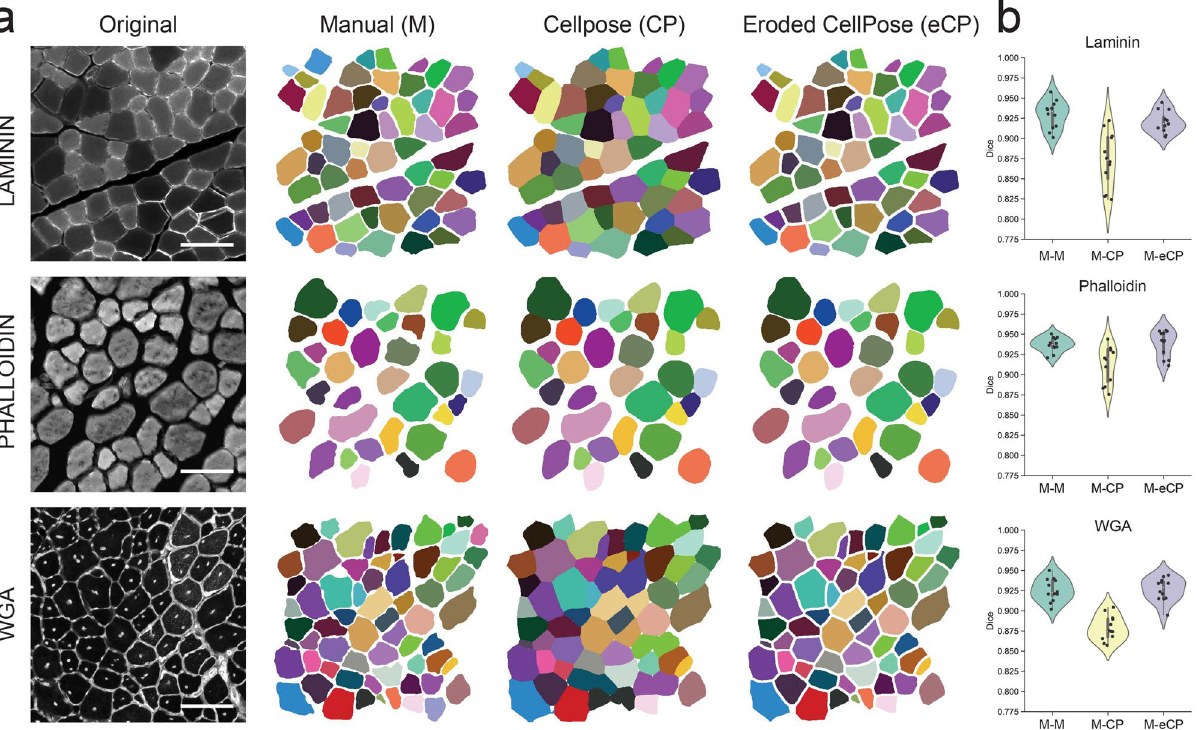
Figure 6. Eroded Cellpose segmentations are as accurate as human experts in delineating myofibers. ( a ) Left, example of cross-sectional TA images marked by Laminin, Phalloidin or WGA and, right, their corresponding labeled images manually generated by a human expert (M), and the original (CP) or the eroded Cellpose segmentation (eCP). ( b ) A set of four images was analyzed for each of the three indicated stains. Three human experts manually segmented each of the images, while those same images were also segmented by Cellpose. Cellpose labels were additionally eroded by a fixed number of pixels according to visual inspection. The Dice coefficient was used to compare the different label images corresponding to the same original image. The violin plot shows the mean Dice coefficient for each human pair for a specific image (M–M), the comparison of human manual segmentations to their associated Cellpose segmentations (M–CP), or for human manual segmentations to their associated Cellpose eroded segmentations